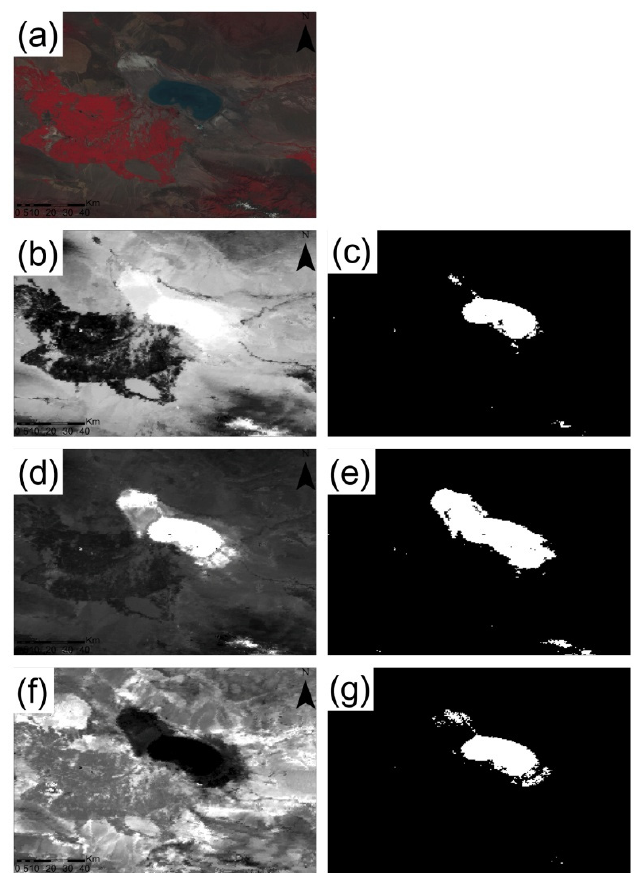
Figure 3. Water body detection results from MODIS data. ( a ) Landsat image; ( b ) NDWI [17]; ( c ) extracted water bodies from NDWI; ( d ) MNDWI [18]; ( e ) extracted water bodies from MNDWI; ( f ) CWI; and ( g ) extracted water bodies from CWI. Water bodies are shown in white in ( c ), ( e ), and ( g